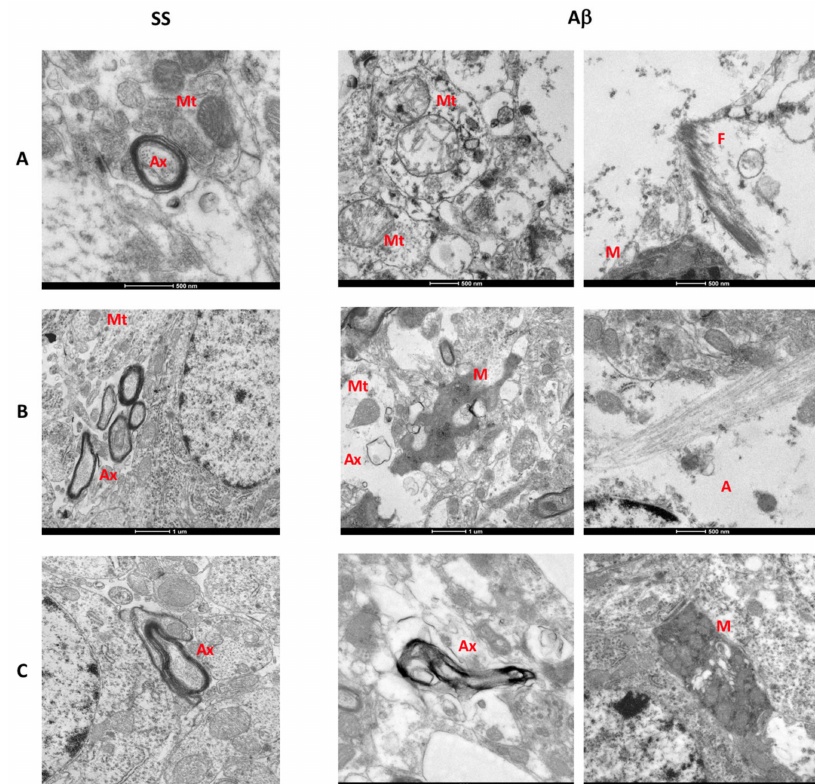
Figure 7. Additional ultrastructural abnormalities. Electron micrographs (Di ff erent scale bars) of ( A ) 7, ( B ) 15, and ( C ) 30 days are shown. Fibrils (F), axon (Ax) degeneration, mitochondrial (Mt) abnormalities and vacuolated microglial (M) cells are present in rats sacrificed after 7 and 15 days of A β O injection. At day 15, we observed microglial processes with vacuoles and swollen astrocytes (A). At day 30 post-injection, cytoplasm disruption, and neuronal loss decreased, but few activated microglia and axon degeneration